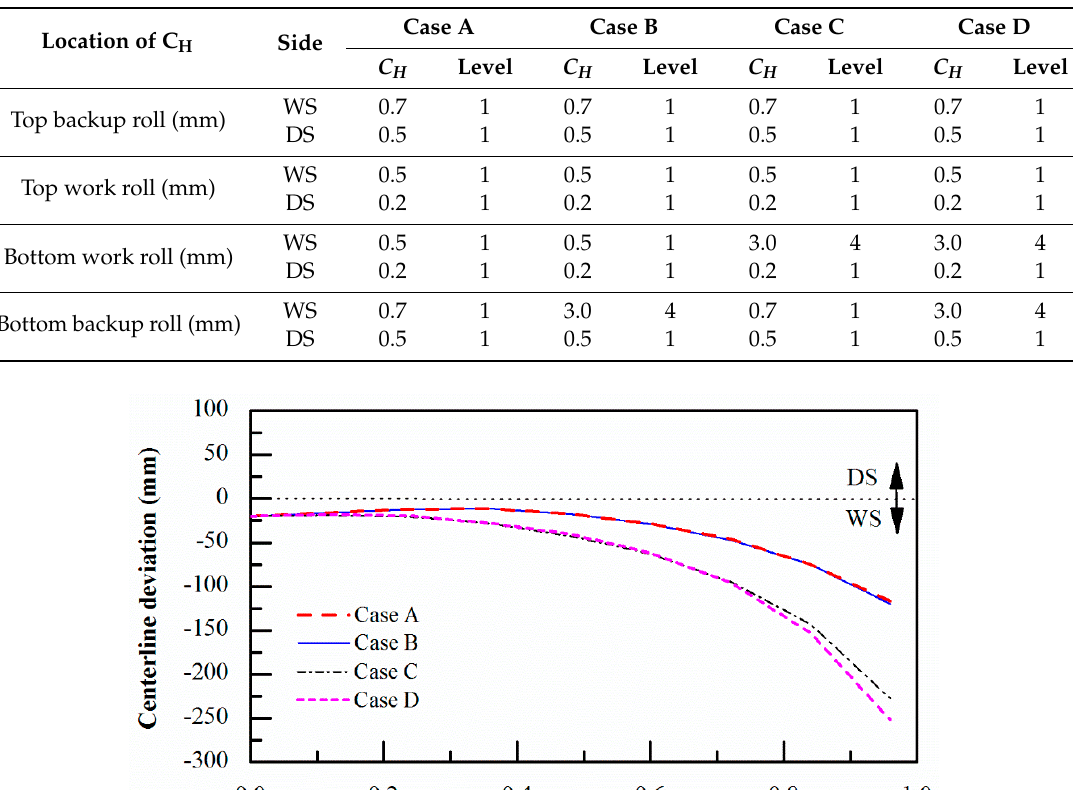
Table 6. The di ff erent asymmetry of horizontal clearances of rolls in the numerical model.